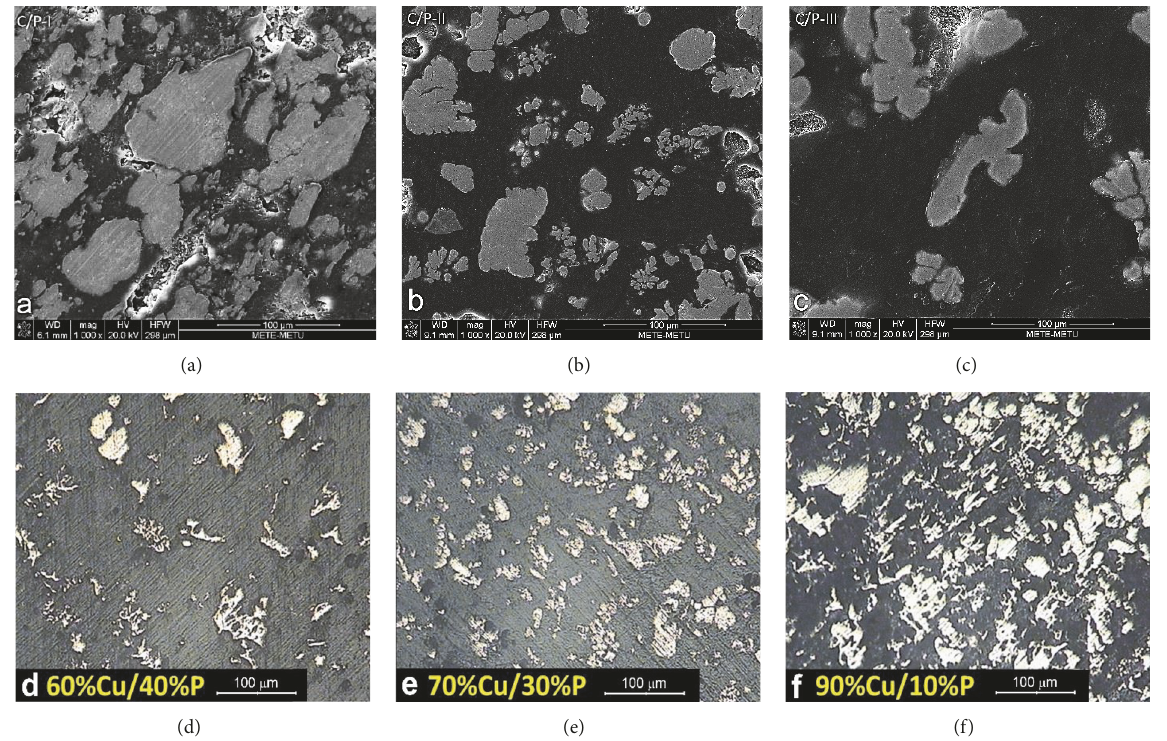
Figure 13: SEM ( × 1000)/Micro ( × 100) images of (a) Cu 86% wt, (b) Cu 75% wt, (c) Cu 60% wt, (d) Cu 60% wt, (e) Cu 70% wt, and (f) Cu 90% wt-polyester composite mixture.